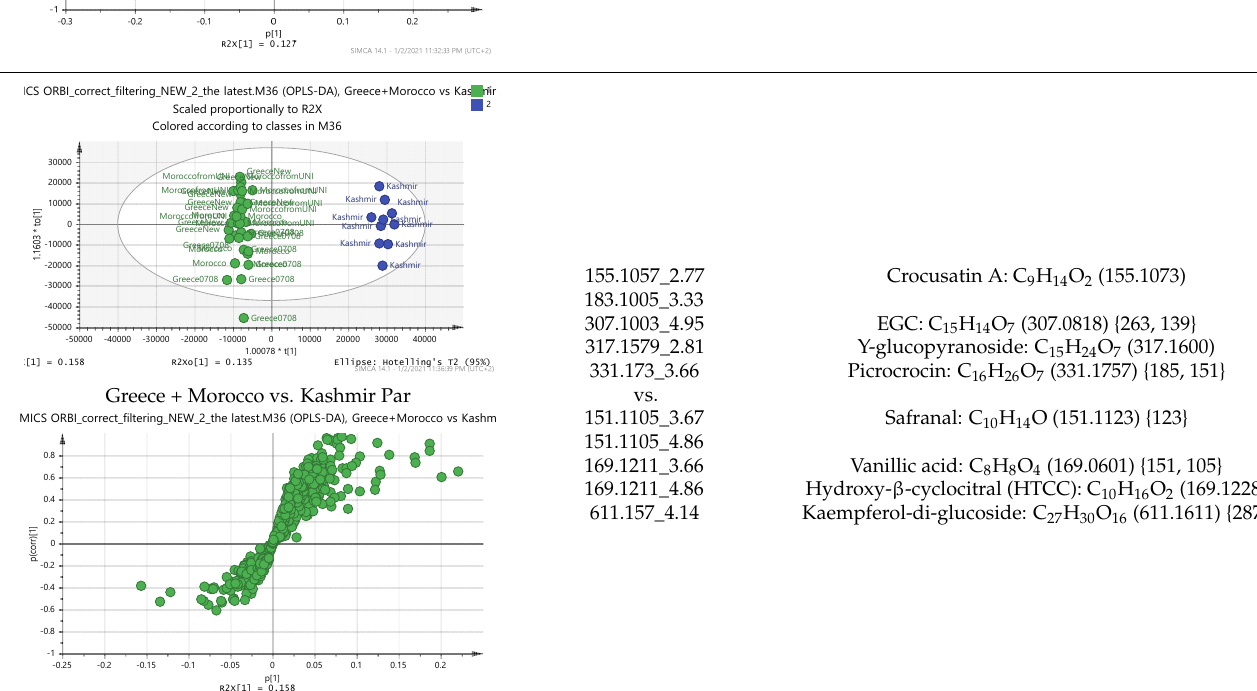
Picrocrocin: C 16 H 26 O 7 (331.1757) {185,